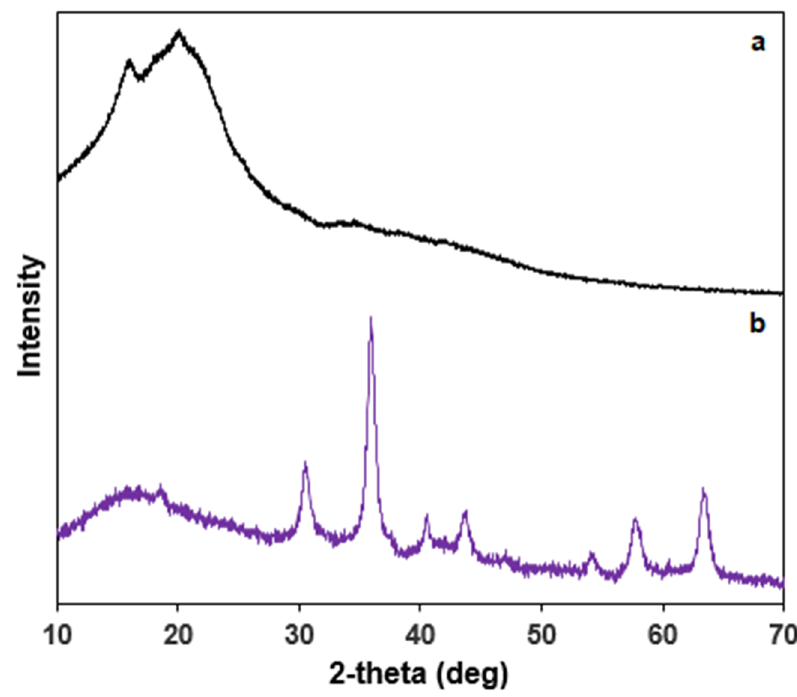
Figure 4. XRD diagram of (a) CWH and (b) Pd-Fe 3 O 4 -CWH nanocatalyst. Figure 3. XRD diagram of ( a ) CWH and ( b ) Pd-Fe 3 O 4 -CWH nanocatalyst.